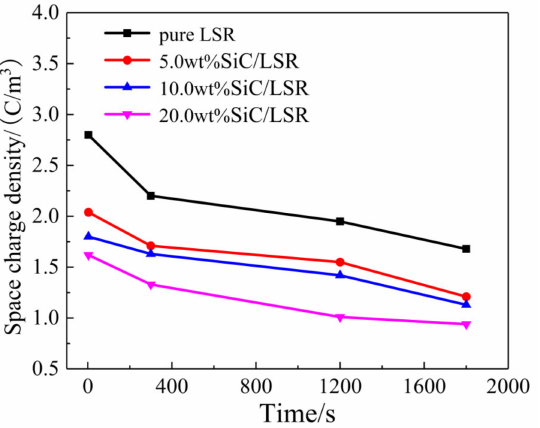
Figure 7. Space charge density of pure LSR and SiC/LSR nanocomposites during